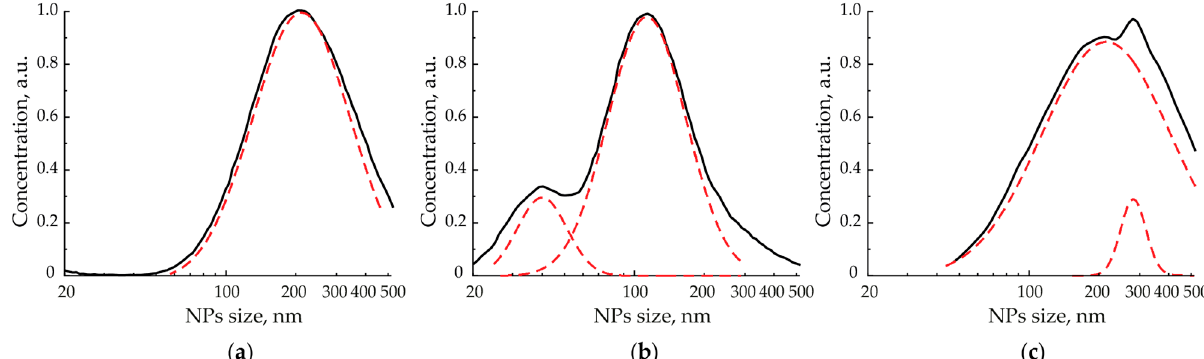
Figure 2. Examples of size distributions for initial ( a ) and laser modified ( b , c ) NPs agglomerates (black curves) with their log ‐ normal multiple peak approximation (dashed red curves). Here, the NPs size axis is provided in the logarithmic scale.